Question: Produce a descriptive caption suitable for publication.
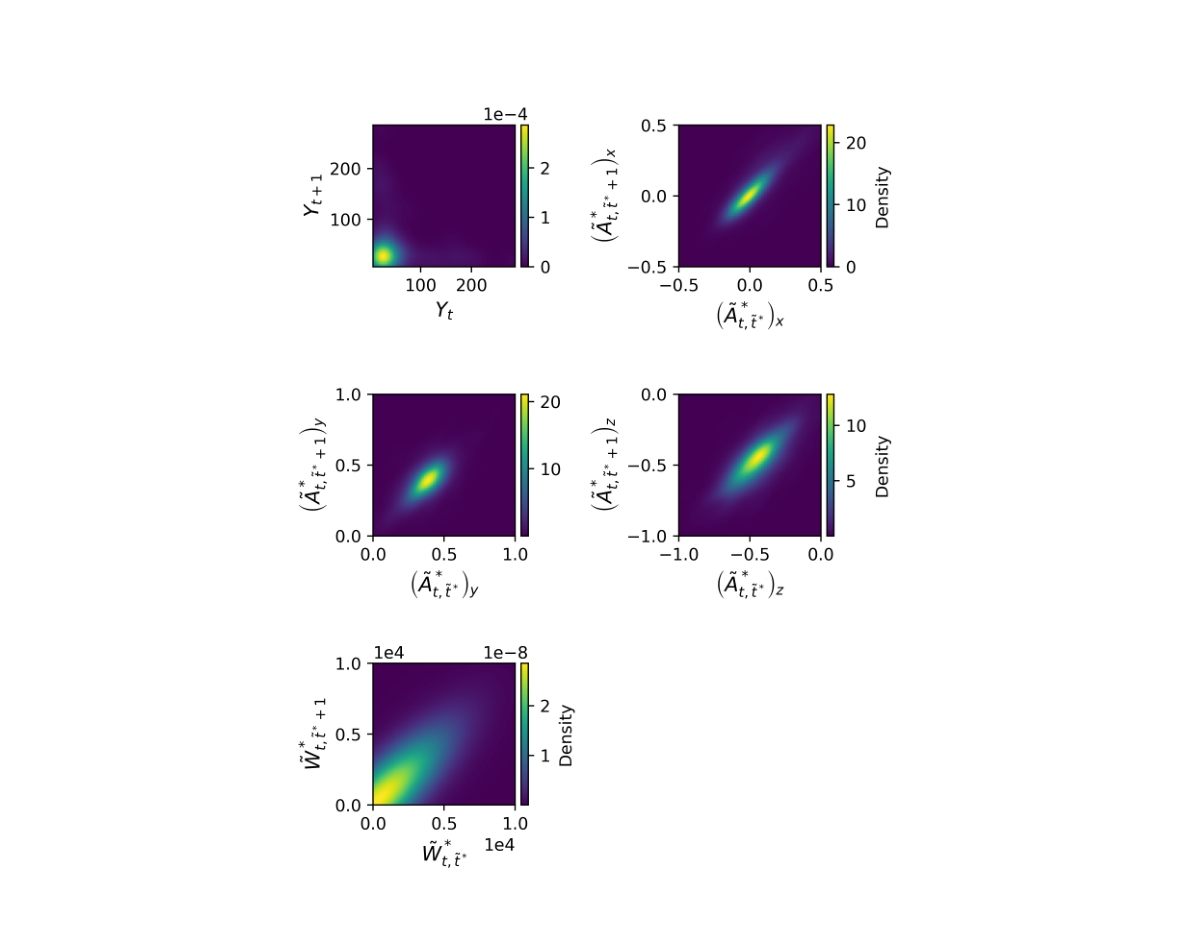
Answer: Collection of 5 lag plots where a given observation is on the x-axis and the subsequent observation is on the y-axis. Each plot corresponds to a feature in the killer whale dive data. Lag plots are used to decide whether to include auto-correlation in the HMMs used to model the killer whale’s kinematic data. They can also be used to determine the number of hidden states if multiple distinct patterns are visible.